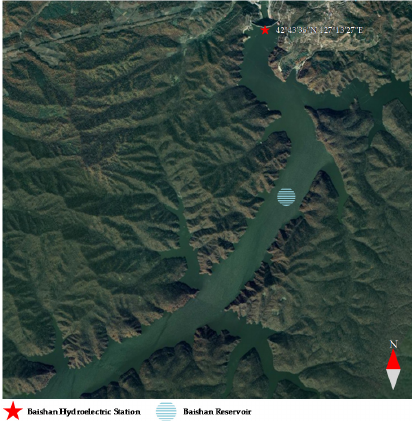
Figure 4. Location of Baishan Hydropower Station.